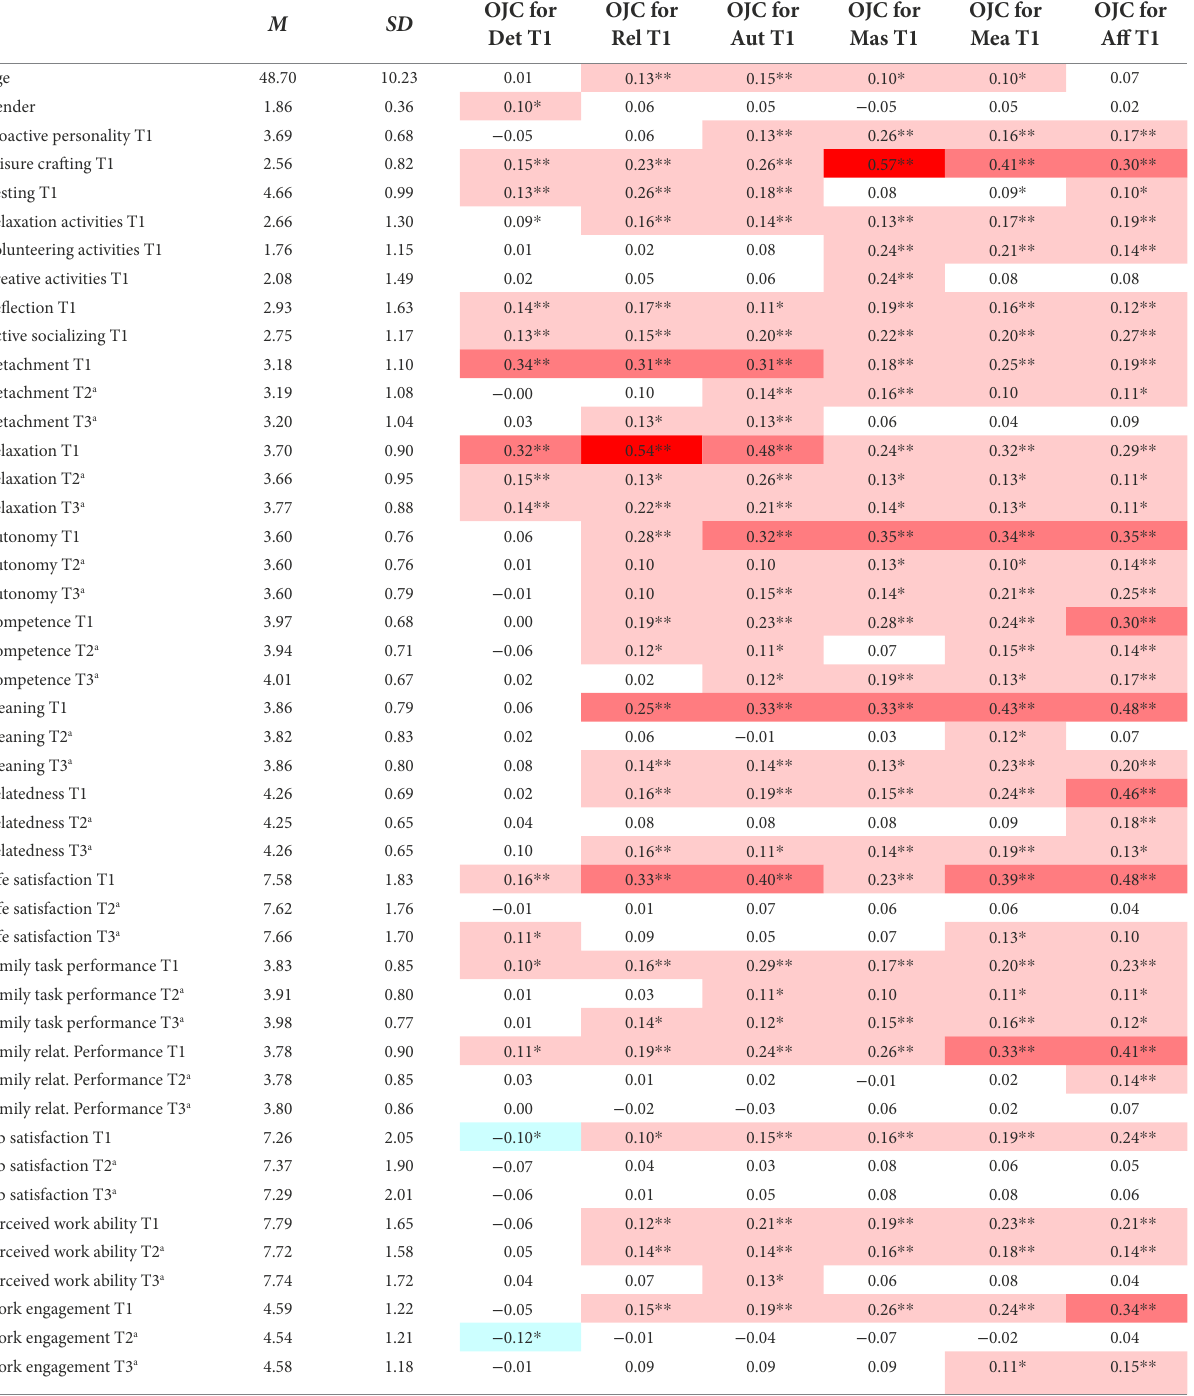
TABLE 6 Zero-order (cross-sectional) correlations and partial correlations of the OJC dimensions, Study 3. OJC M SD